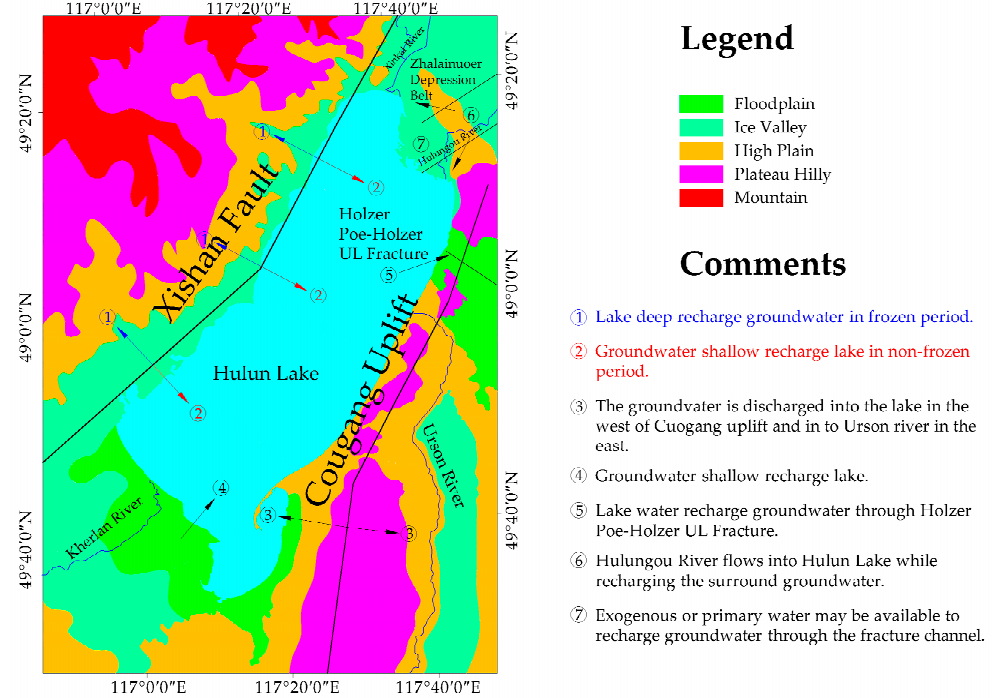
Figure 6. The recharge/discharge relationship of the lake and groundwater in Lake Hulun.